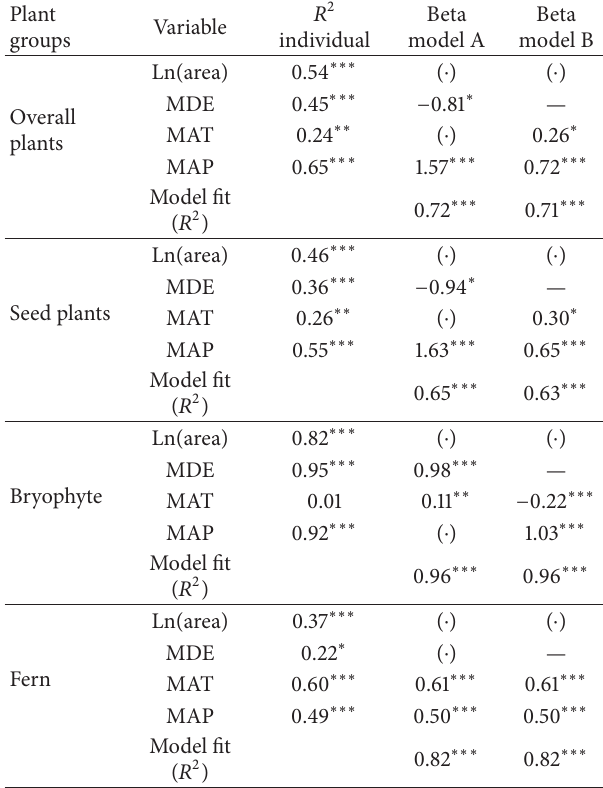
Table 2: Coefficients of determination ( 𝑅 2 ) between species rich- ness and explanatory variables for each plant group in simple linear regression analysis; standard coefficients (beta) for each variable and model fit ( 𝑅 2 ) in stepwise multiple